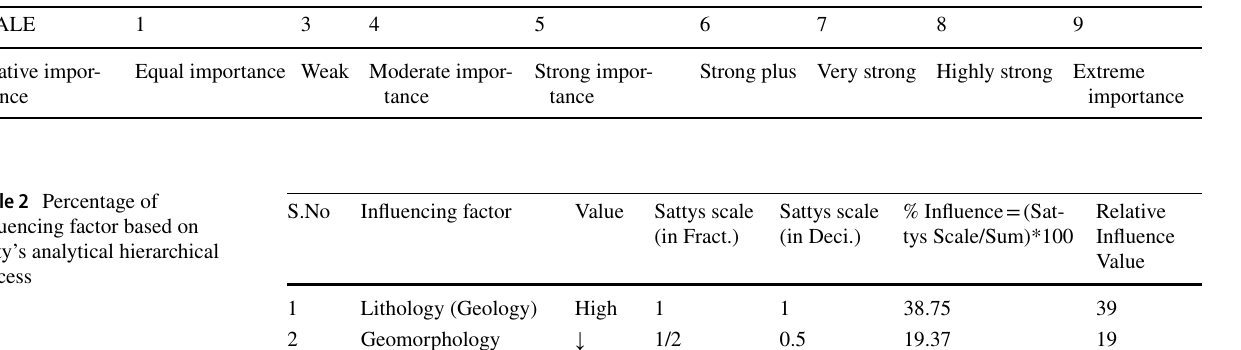
Table 1 Saaty’s Scale of relative importance SCALE